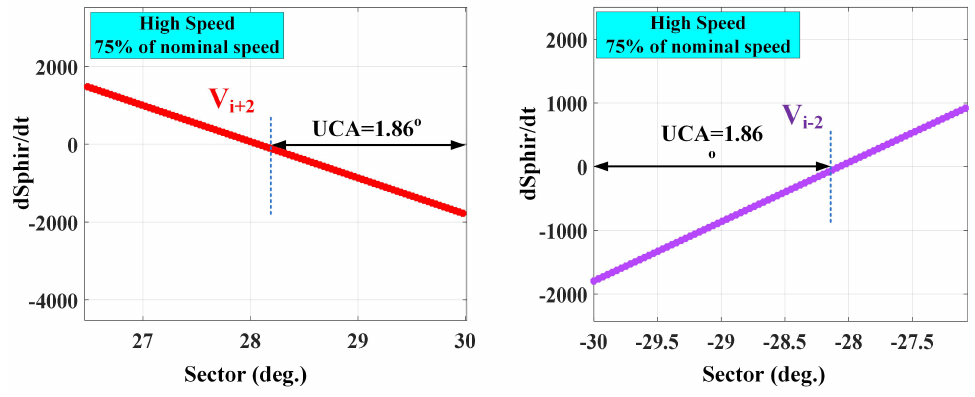
Figure 5. UCA of V i + 2 or V i − 2 on dS Φ r for high speed ( 75% ω n ) .